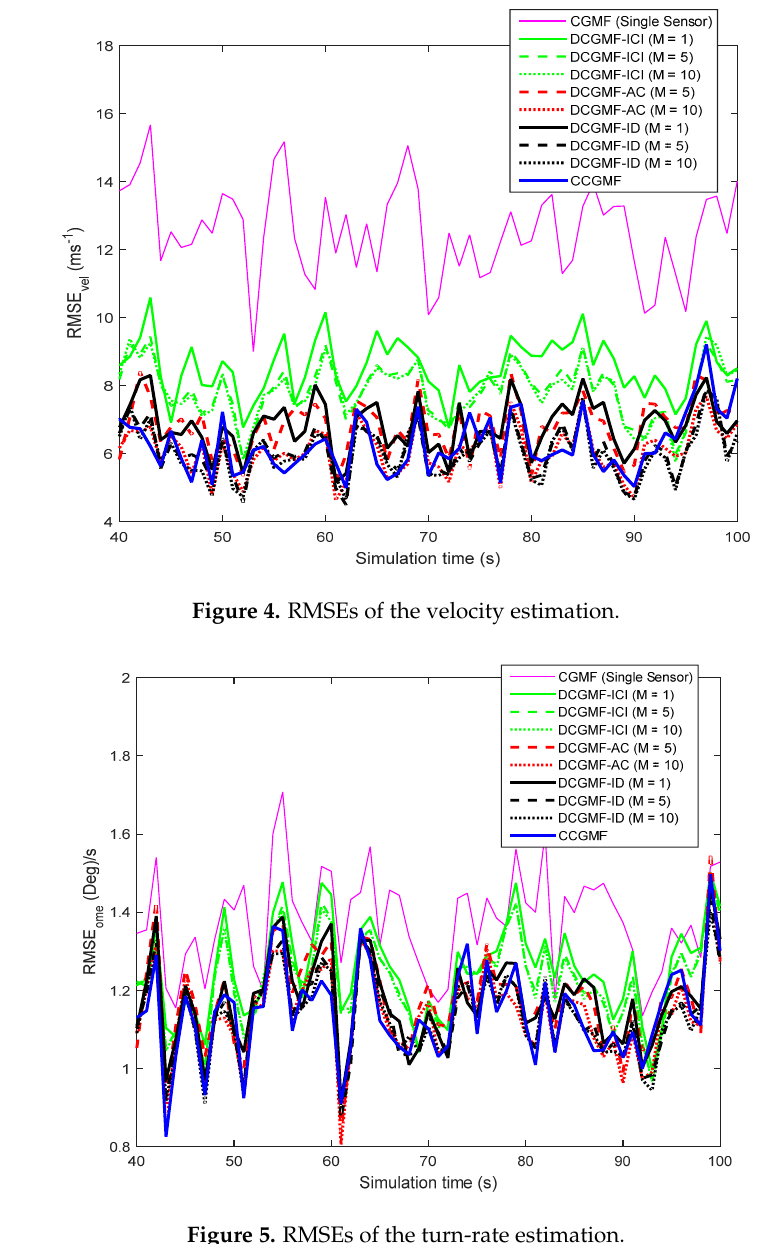
Figure 5. RMSEs of the turn-rate estimation.